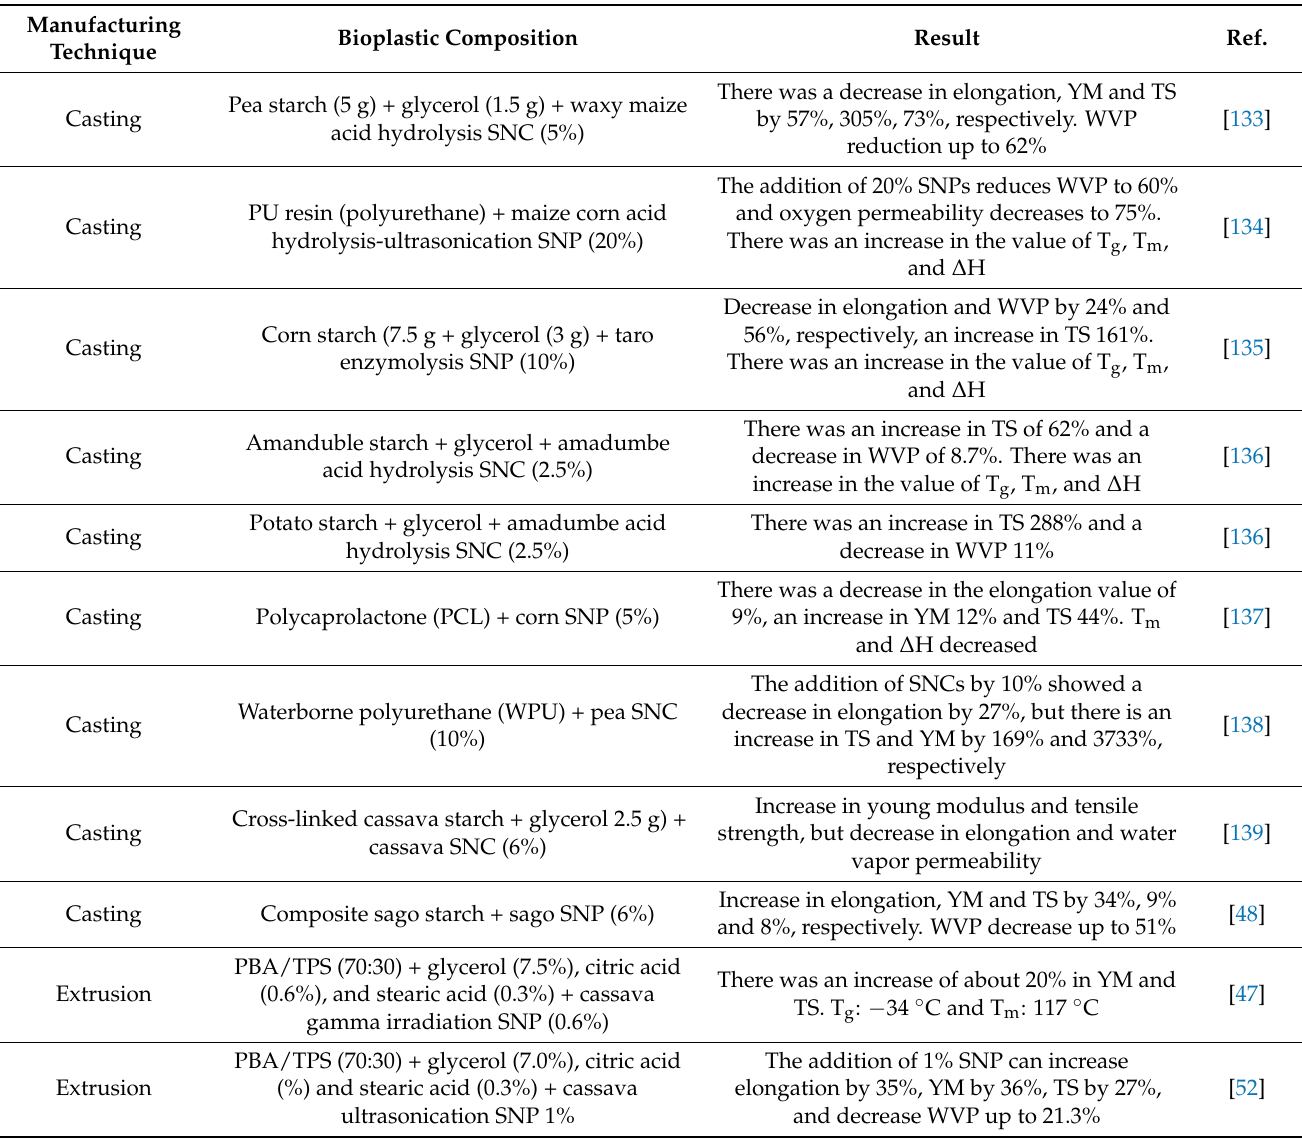
Table 6. Application of SNPs compared with SNCs as Fillers in